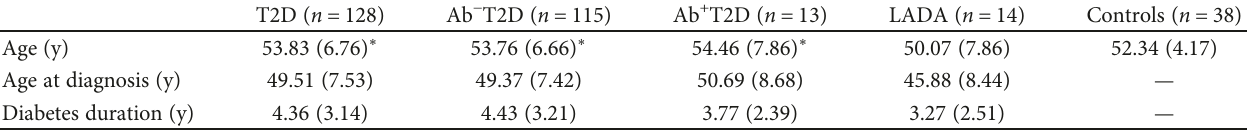
Table 2: Age, duration of diabetes, and age at diagnosis of diabetic patients and control subjects. T2D ( n = 128 )